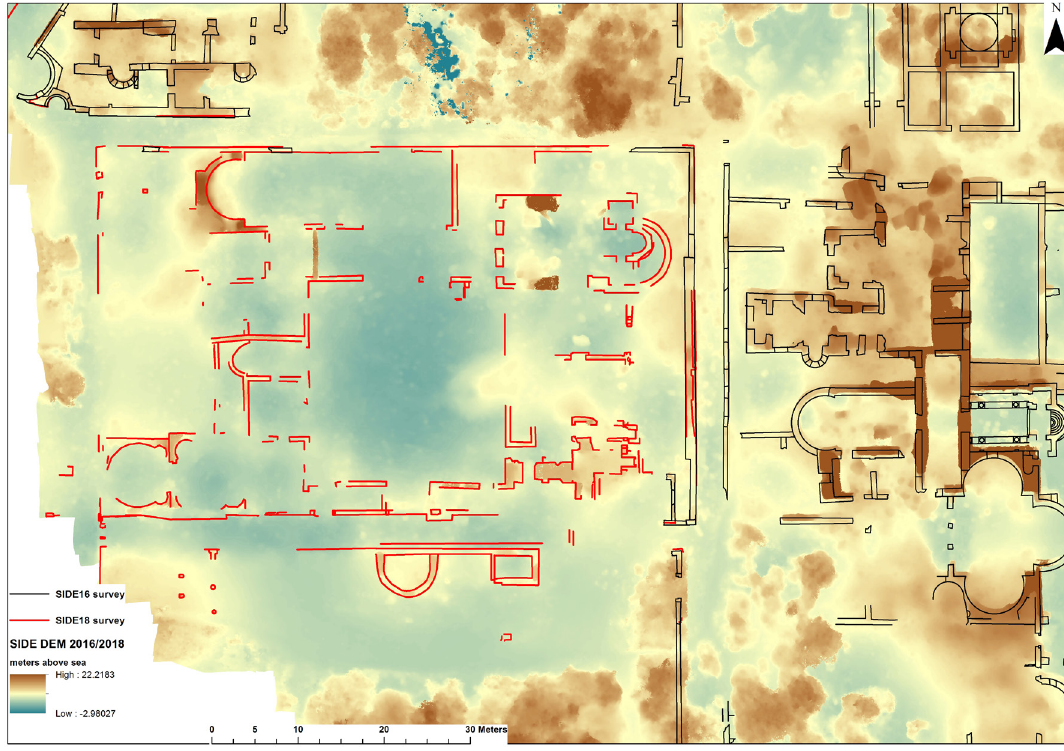
Figure 8. 2016 and 2018 field campaigns survey and DEM generated in Agisoft Photoscan 1.4.4 © ÖAW/IKAnt (M. Hernández